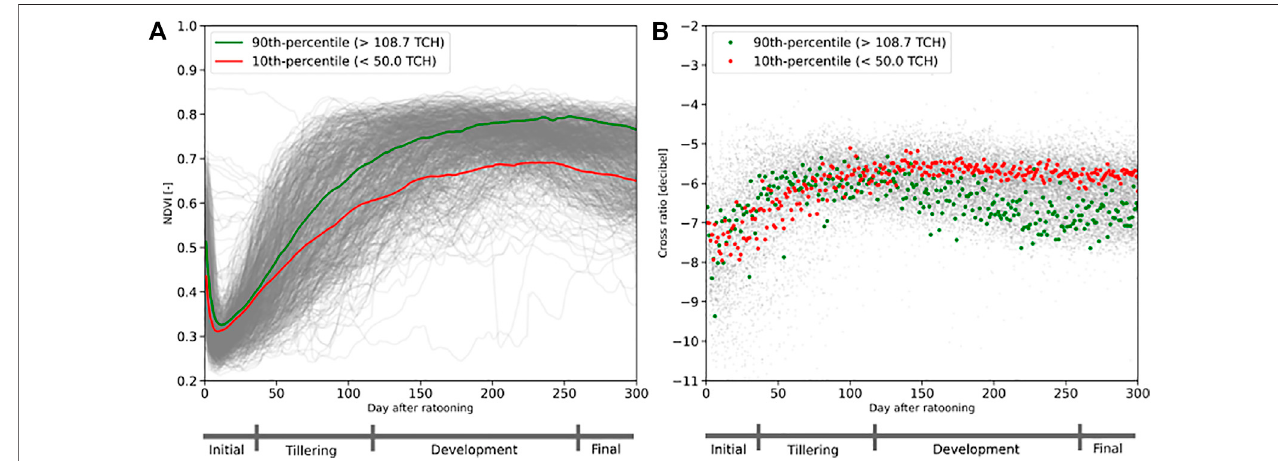
FIGURE2|(A) NDVItimeseriesofthe fi eldsunderstudyoverthegrowingseason.Eachgraylinecorrespondstoasingle fi eld. (B) Crossratiotimeseriesofthe fi elds under study. The green and red dots display the average values of fi elds with ayield above the 90th percentile ( > 108.7 TCH) and below the 10th percentile ( < 50.0 TCH). The bar below the fi gure indicates the length of the different crop stages.